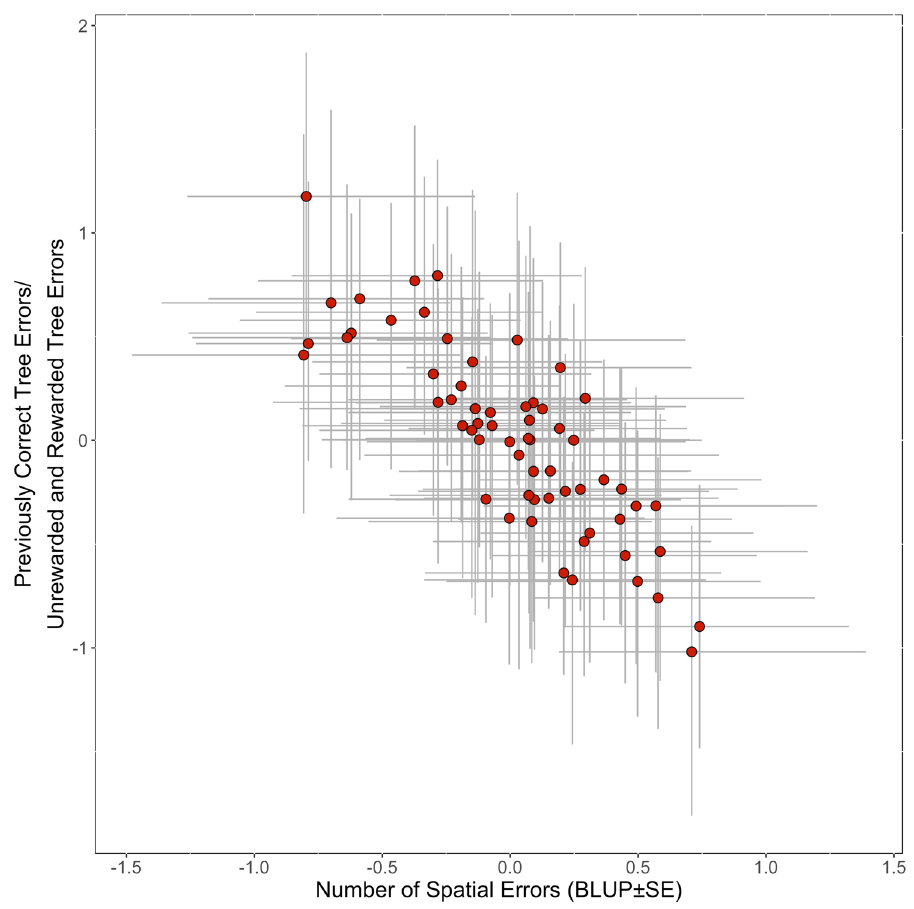
Figure 4. Among-individual correlation (red) between the standardized number of spatial errors and the standardized number of errors made to the previously rewarded tree/unrewarded and rewarded trees in great tits ( Parus major ) from high and low elevations. Individual deviations from the population mean are illustrated using best linear unbiased predictors (BLUP ± SE) associated with the random effect of bird